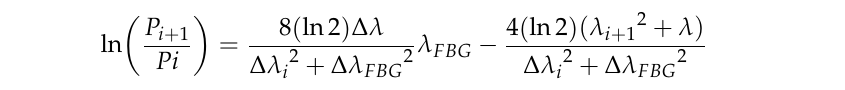
Figure 2. FBG spectra in pace with the spectrum from two AWG channels.